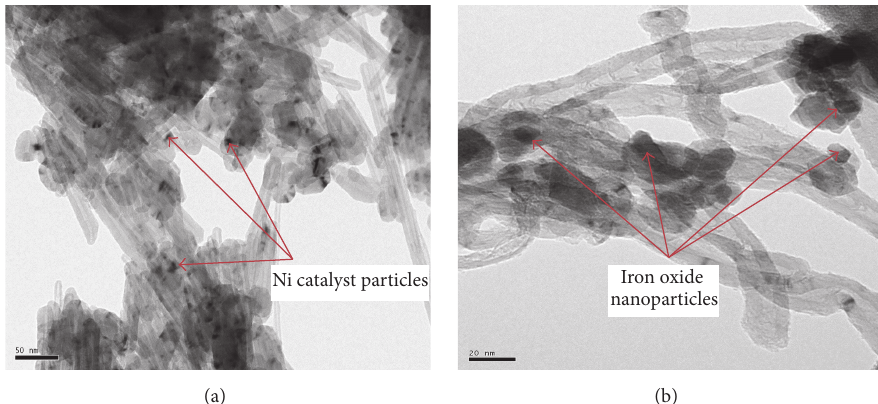
Figure 3: TEM images of (a) pure and (b) iron oxide impregnated